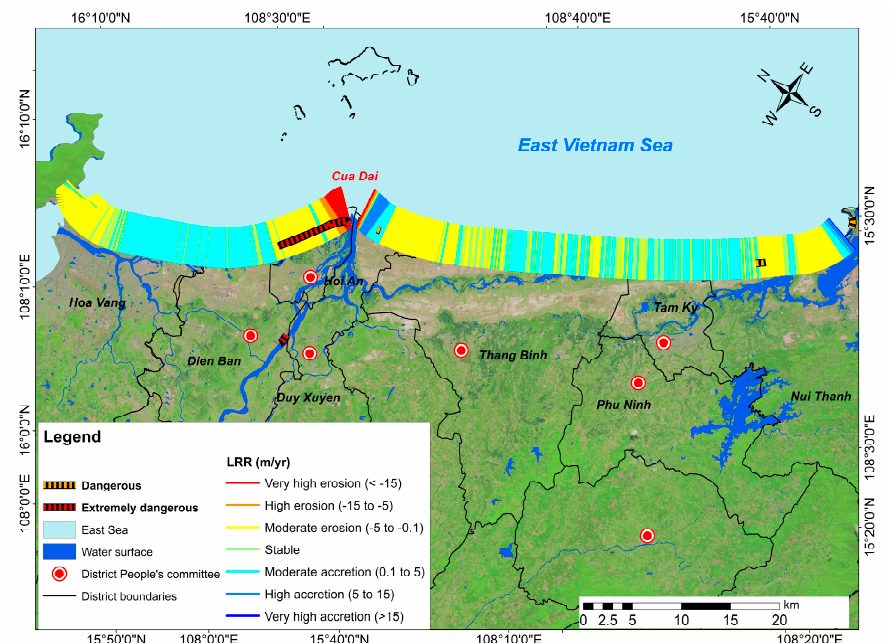
Figure 13. Spatial variation of Quang Nam coastline by using DSAS technique.